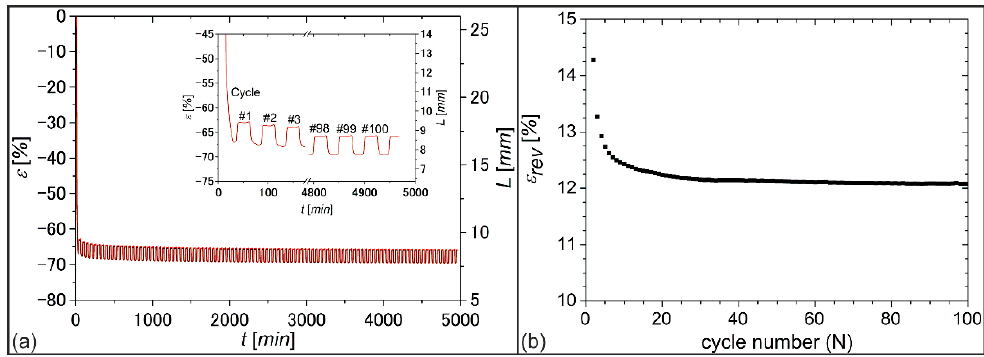
Figure 8. DMA measurement to determine the durability of actuation for PDA-based PEU: evolu- tion of ( a ) nominal strain ε with time t and ( b ) thermoreversible strain ε rev with cycle number N. of ( a ) nominal strain ε with time t and ( b ) thermoreversible strain ε